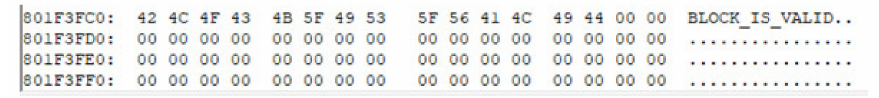
Figure 4. Validity model in